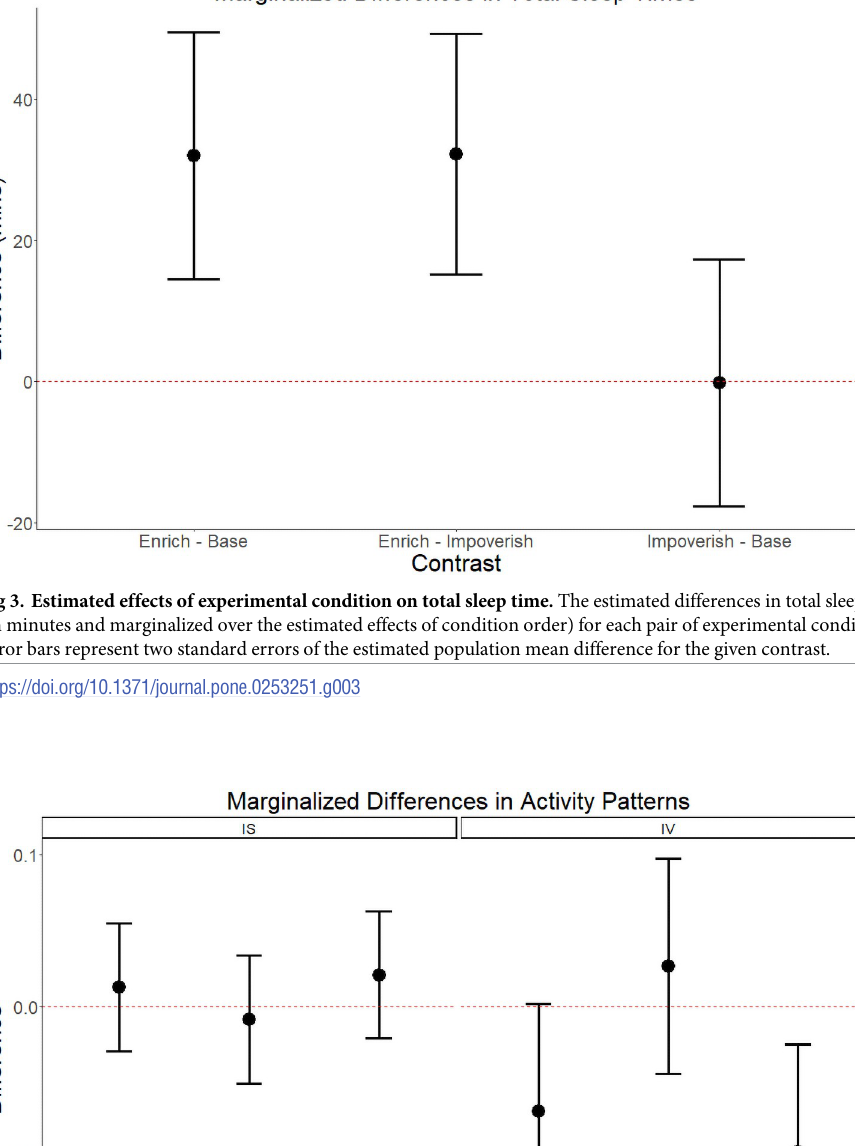
PLOS ONE | https://doi.org/10.1371/journal.pone.0253251 November1,